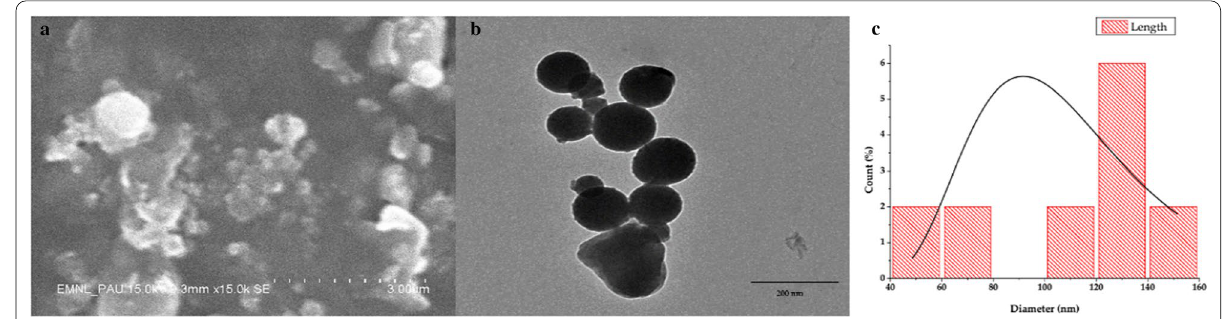
Fig. 1 Electron microscopy characterization a scanning electron micrograph depicting small‑sized aggregates, b transmission electron micrographs of zinc oxide nanoparticles showing spherical shaped nanoparticles, c histogram showing size distribution